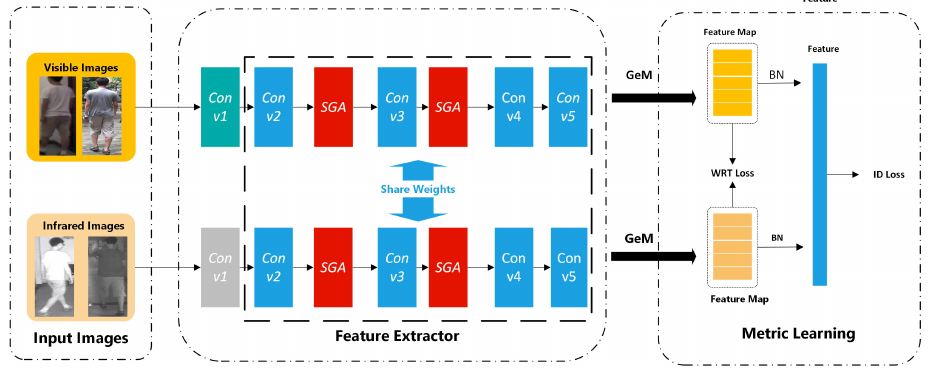
Figure 2. MFCNet. The model in this paper is a two-stream (one RGB image and one infrared image) end-to-end architecture that includes image inputs, feature extraction, and loss measurement. The feature extraction process uses ResNet50 as the backbone network, and the convolutional layer parameters from the first layer are not shared. The remaining convolutional layer parameters are shared to obtain middle features. In this paper, MFCNet with the same shared parameters is embedded into the network to capture key discriminative features, and WRT loss and ID loss are used for network training to improve network performance. This figure is best viewed in